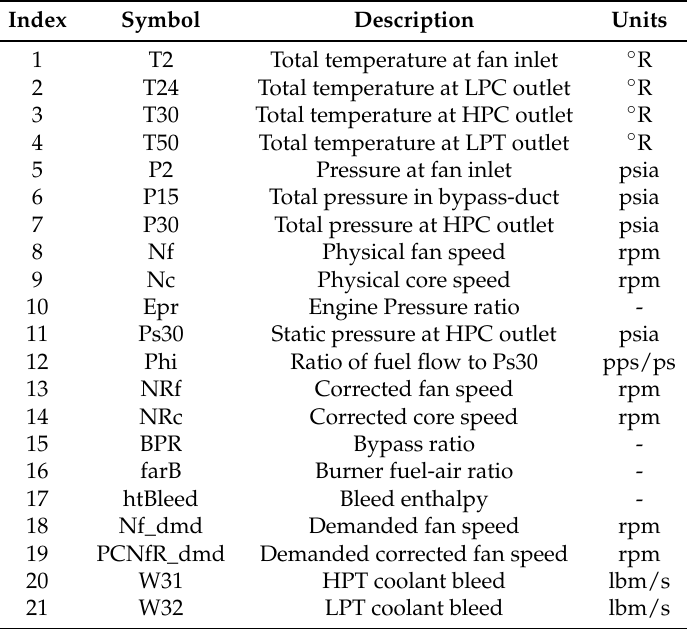
Table 1. Description of sensor signals